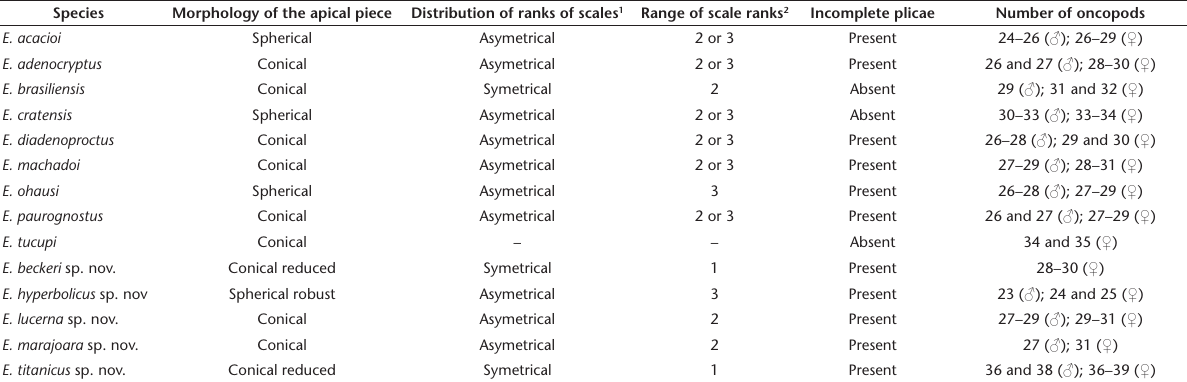
Table 1. The main characteristics present in the Brazilian Epiperipatus species.